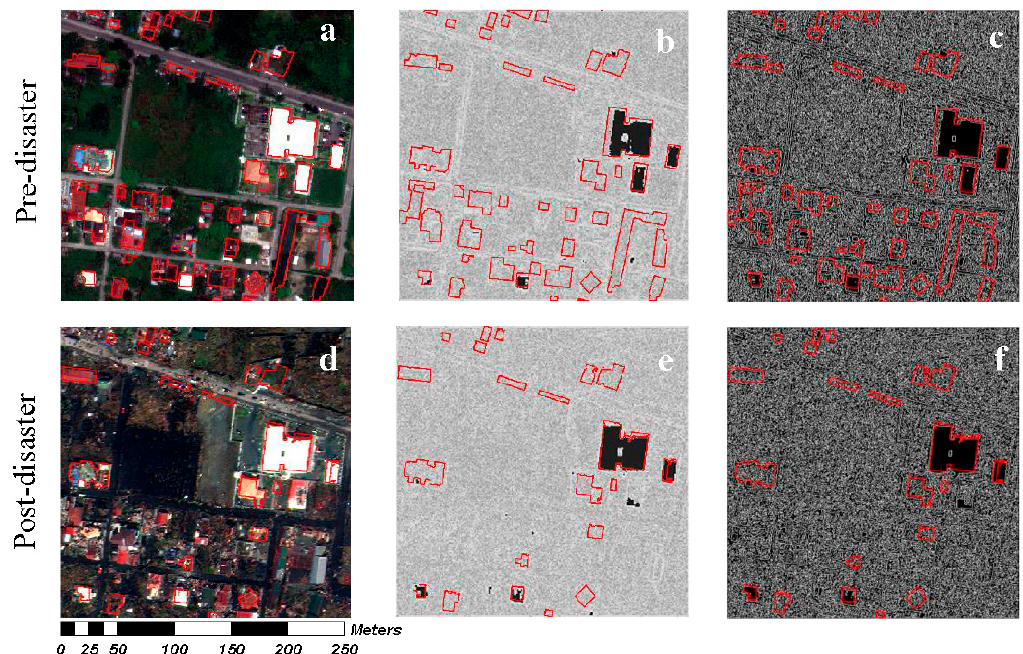
Figure 3. ( a – c ) Pre-disaster data in terms of ( a ) multispectral image, ( b ) V-HOG, and ( c ) edge detection image; OSM building map denoted with red lines. ( d – f ) Event time data in terms of ( d ) multispectral image, ( e ) V-HOG, and ( f ) edge detection image; the result of Step 3 is denoted with red lines.